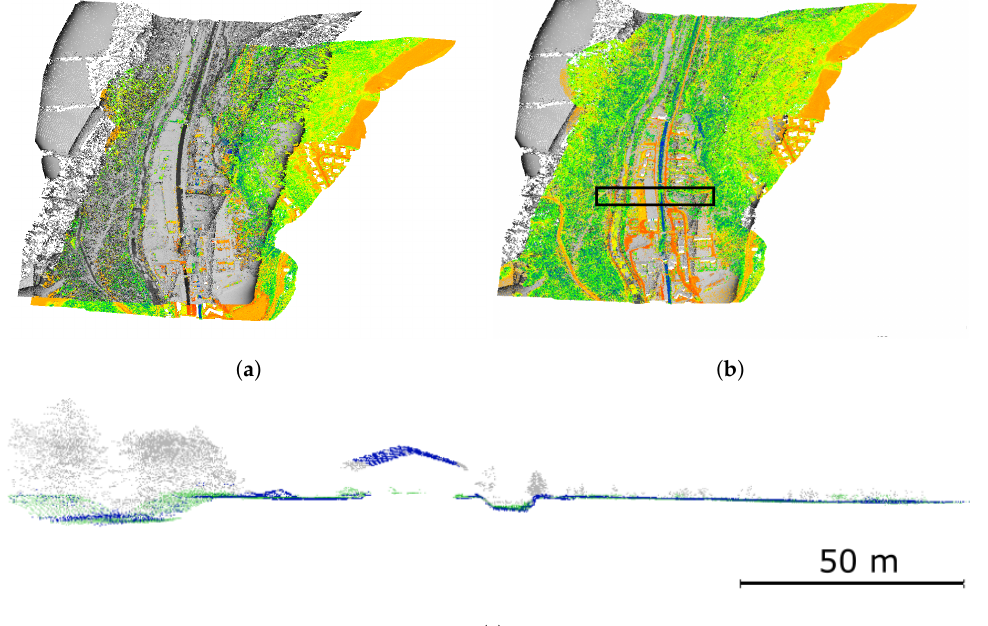
Figure 4. Result of the proposed approach shown on the first scene. ( a ) Overview of the first scene with initial transformation. ( b ) Overview of the first scene with registration result. ( c ) Profile view of the marked area in ( b ). Shown data are the original data of 2012 and the data of 2017 downsampled to 0.5 m GSD. The color representation is the same as in Figure 3.